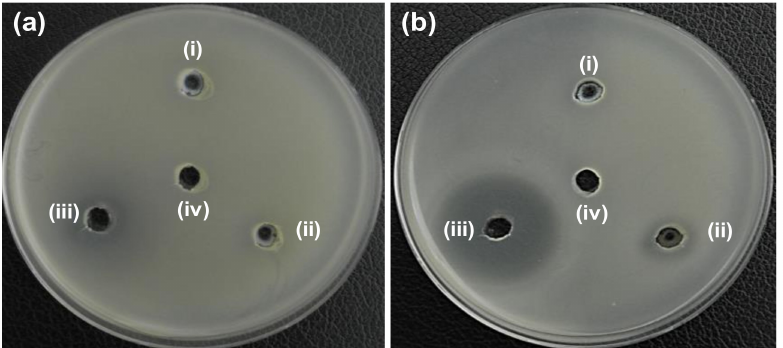
Figure 4. Determination of zone of inhibition (ZOI) for ZO and AZO samples against ( a ) E. coli and ( b ) S. aureus . (i), (ii), (iii), and (iv) represents ZO, AZO, erythromycin (Ery) and deionized water (DW), respectively. Diameter of ZOI measured by ruler is shown in Table 1 (average from n = 3).